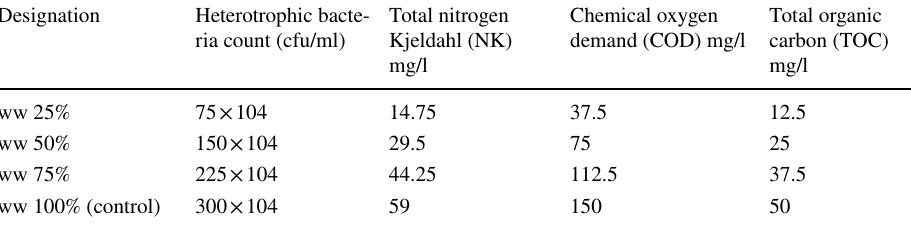
Table 2 Distribution of the initial concentrations of the different wastewater samples (ww) at the start of the